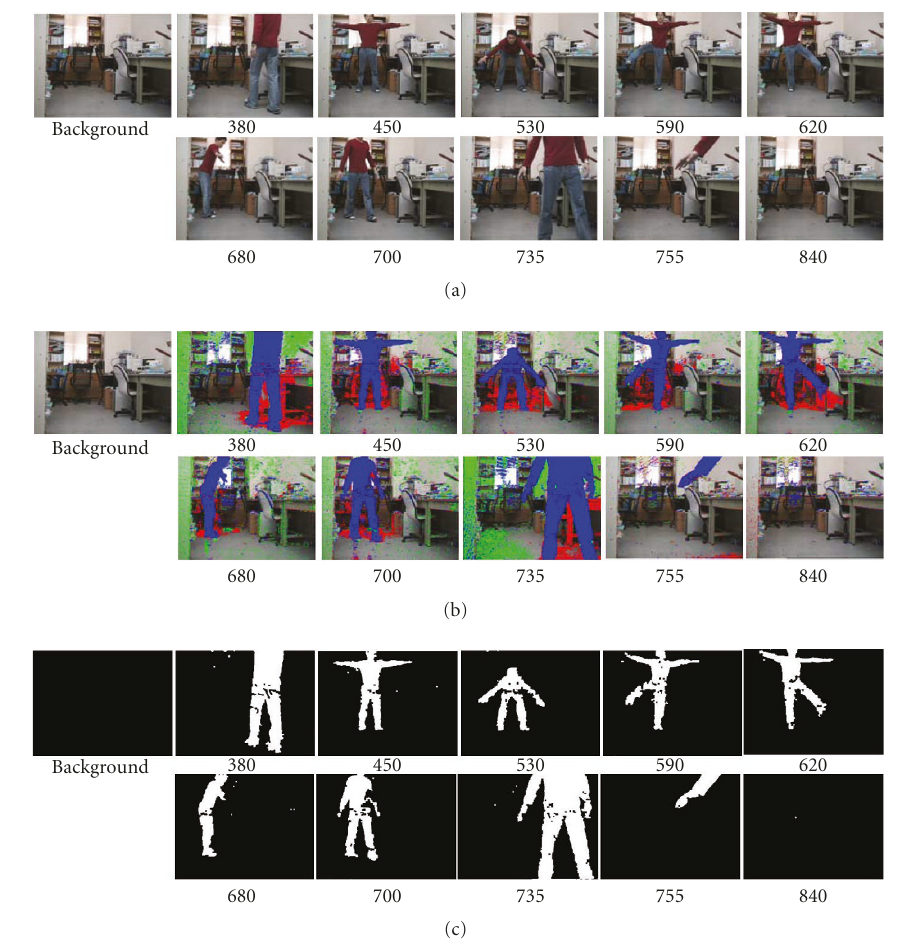
Figure 9: The results of foreground detection, (a) original images, (b) the results of pixel classification, where the red color indicates the shadow, green indicates the highlight, and blue indicates the foreground, (c) the results of background subtraction with shadow removal using our proposed method, where dark indicates the background and white indicates the foreground. Table 5: The comparison between the proposed method and that proposed by Hoprasert et al. [13] via foreground detection.